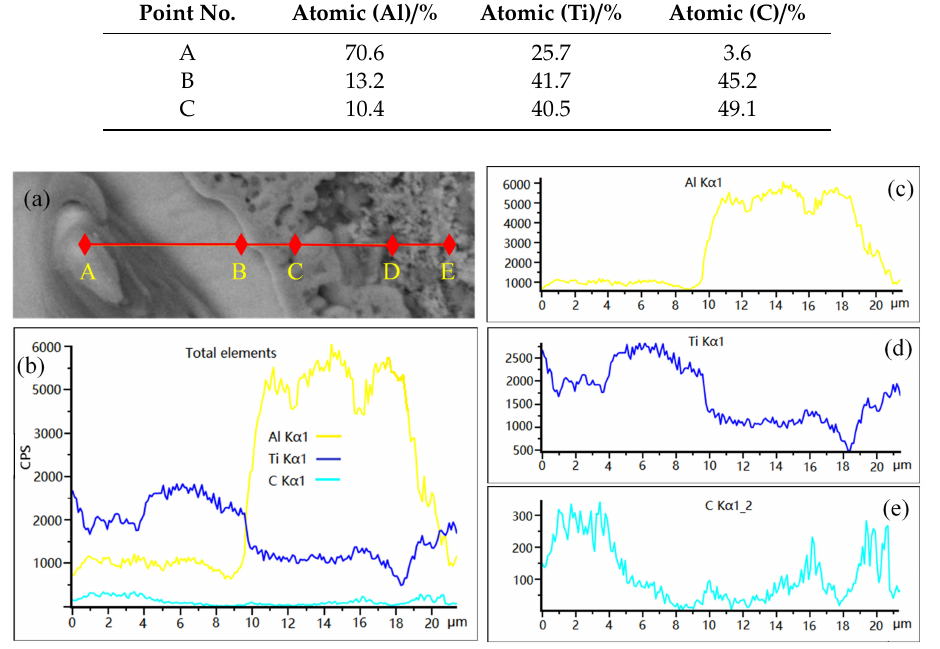
Figure 12. SEM image and line scan patterns of Line 1 of Figure 11a: ( a ) SEM image; ( b ) line scan patterns of all elements; ( c – e ) line scan patterns of Al, Ti, and C,